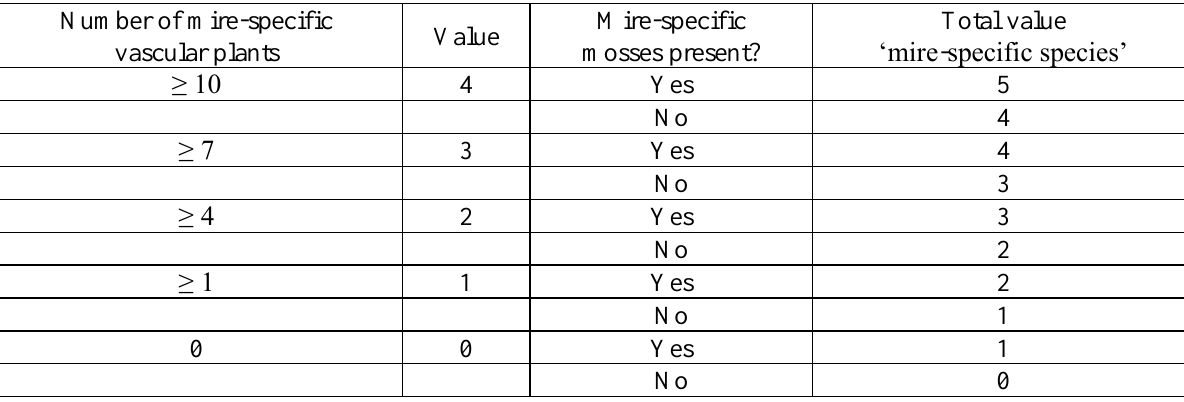
Table 8. Value scale for indicator ‘mire-specific species’ based on number of mire-specific vascular plants and presence of mire-specific mosses (species